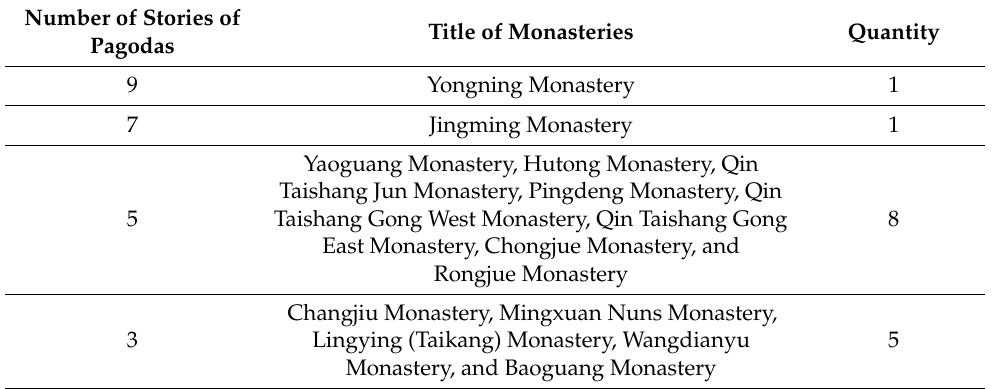
Table 1. Statistics of the monasteries with pagodas above three stories in Luoyang of the Northern